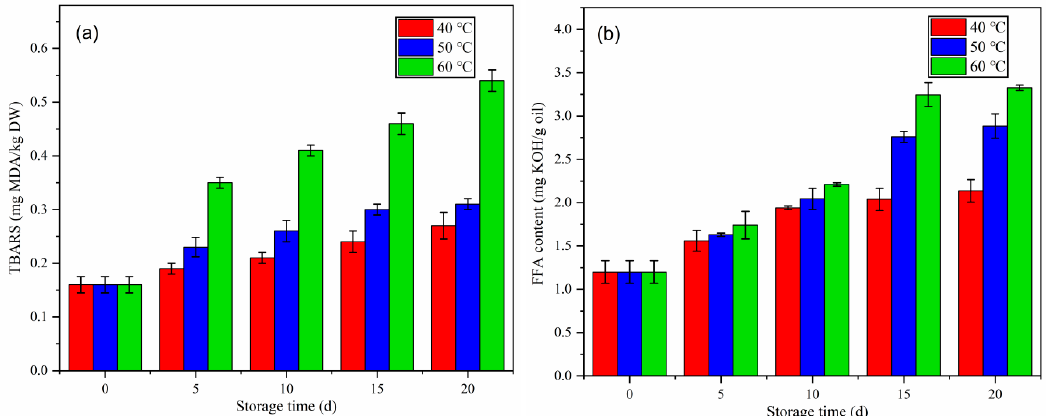
Figure 2. Changes in the thiobarbituric acid reactive substances (TBARS) ( a ) and free fatty acid (FFA) content ( b ) in green coffee beans during accelerated